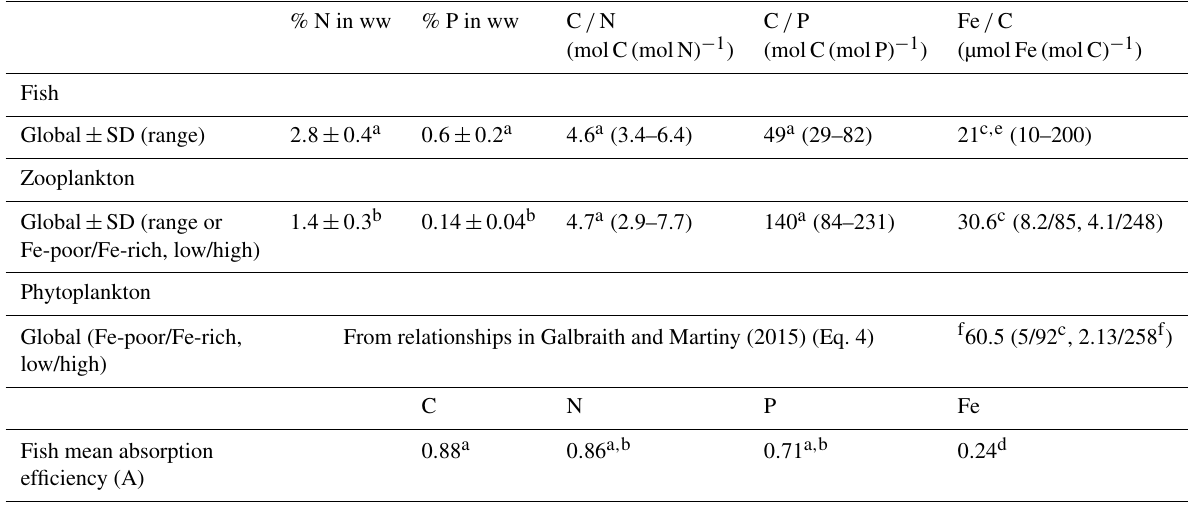
Table 1. Mean nutrient content in fish, zooplankton, and phytoplankton and mean absorption efficiencies (A) of N, P, and Fe for fish used in this study. % N in